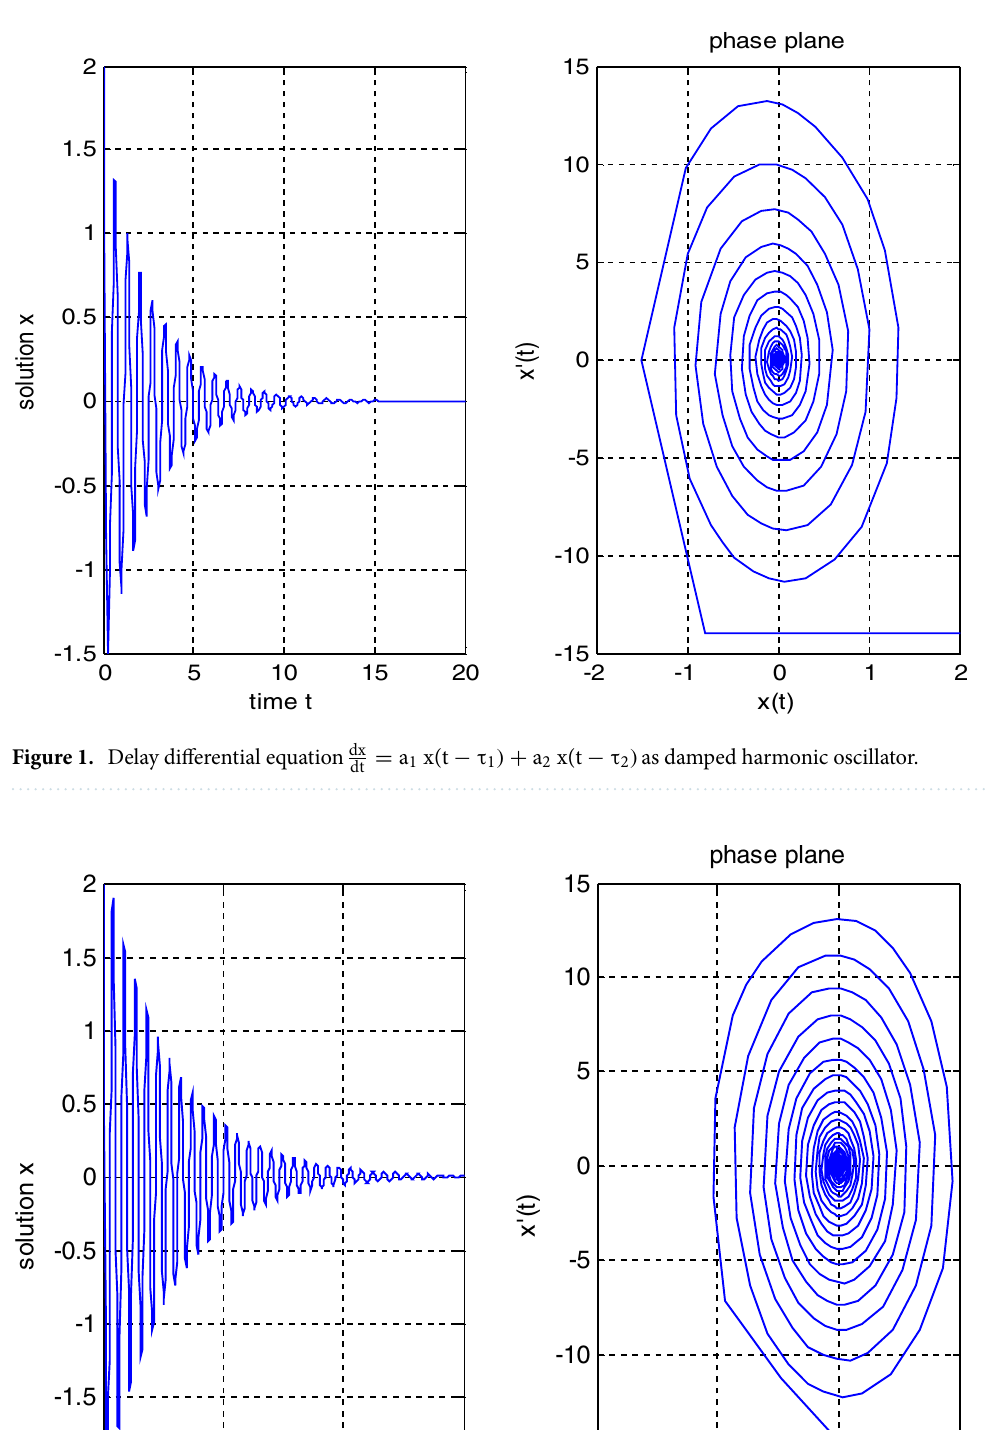
a 1 x(t a 2 x(t τ 1 ) τ 2 ) , a 1 < 0, a 2 < 0 = − + −